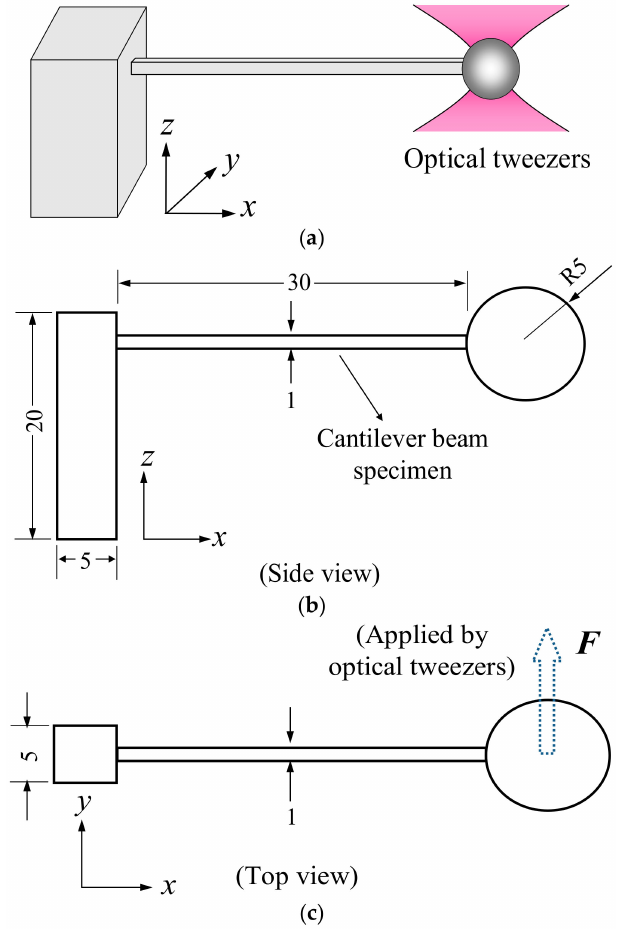
Figure 2. ( a ) Overall design of the specimen; ( b ) Side view; ( c ) Top view (dimensions in µ m). A 5 µ m diameter sphere was fabricated at the tip of the bar for facilitating force application. By dragging the sphere sideways using optical tweezers, a horizontal force is applied to bend the cantilever